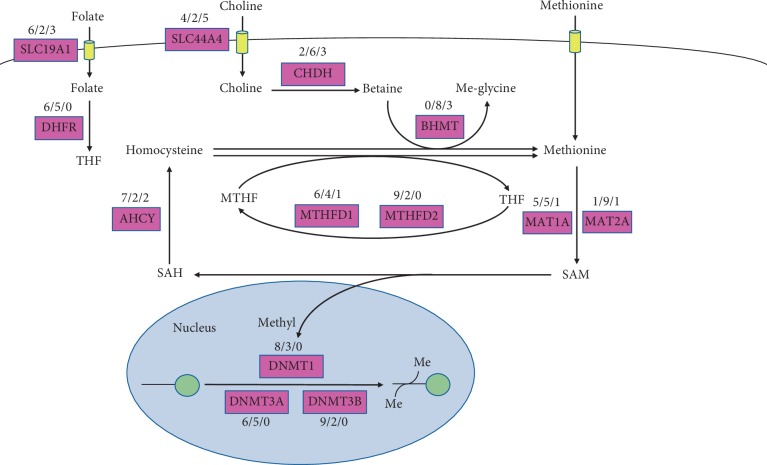
Detailed network map of transmethylation of gene expression levels in the 11 cancer types. Note: each metabolic reaction is marked with the number of tumors (out of 11 considered in our analysis) in which at least one gene in the corresponding reaction is significantly (FDR < 0.05) upregulated (red), downregulated (green), and neutral (black). If unmarked, no statistically significant change in mRNA expression was detected. There were three metabolites as methyl donors: methionine, folate, and betaine. All of them provided the methyl group to SAM through their metabolic cycle. Betaine was produced from choline by CHDH. The transporters of choline and folate were SLC44A4 and SLC19A1. Methionine and ATP were catalyzed into SAM by MATs. SAM donated its methyl group to DNA or histone in reactions catalyzed by MTs: DNMT1, DNMT3A, and DNMT3B. SAH was the byproduct of methylation reactions process from SAM. Then, SAH was regulated by the enzyme AHCY, which reversibly made this metabolite into adenosine and homocysteine. Homocysteine was used to produce methionine with the demethylation of folate and betaine through two enzymes: MS and BHMT. SLC19A1: solute carrier family 19 member 1; SLC44A4: solute carrier family 44 member 4; DHFR: dihydrofolate reductase; CHDH: choline dehydrogenase; BHMT: betaine-homocysteine S-methyltransferase; AHCY: adenosylhomocysteinase; MTHFD1: methylenetetrahydrofolate dehydrogenase, cyclohydrolase, and formyltetrahydrofolate synthetase 1; MTHFD2: methylenetetrahydrofolate dehydrogenase (NADP + dependent) 2, methenyltetrahydrofolate cyclohydrolase; MAT1A: methionine adenosyltransferase 1A; MAT2A: methionine adenosyltransferase 2A; DNMT1: DNA methyltransferase 1; DNMT3A: DNA methyltransferase 3 alpha; DNMT3B: DNA methyltransferase 3 beta; THF: tetrahydrofuran; MTHF: methyltetrahydrofolate; SAM: S-adenosyl-L-methionine; SAH: S-adenosyl-L-homocysteine.